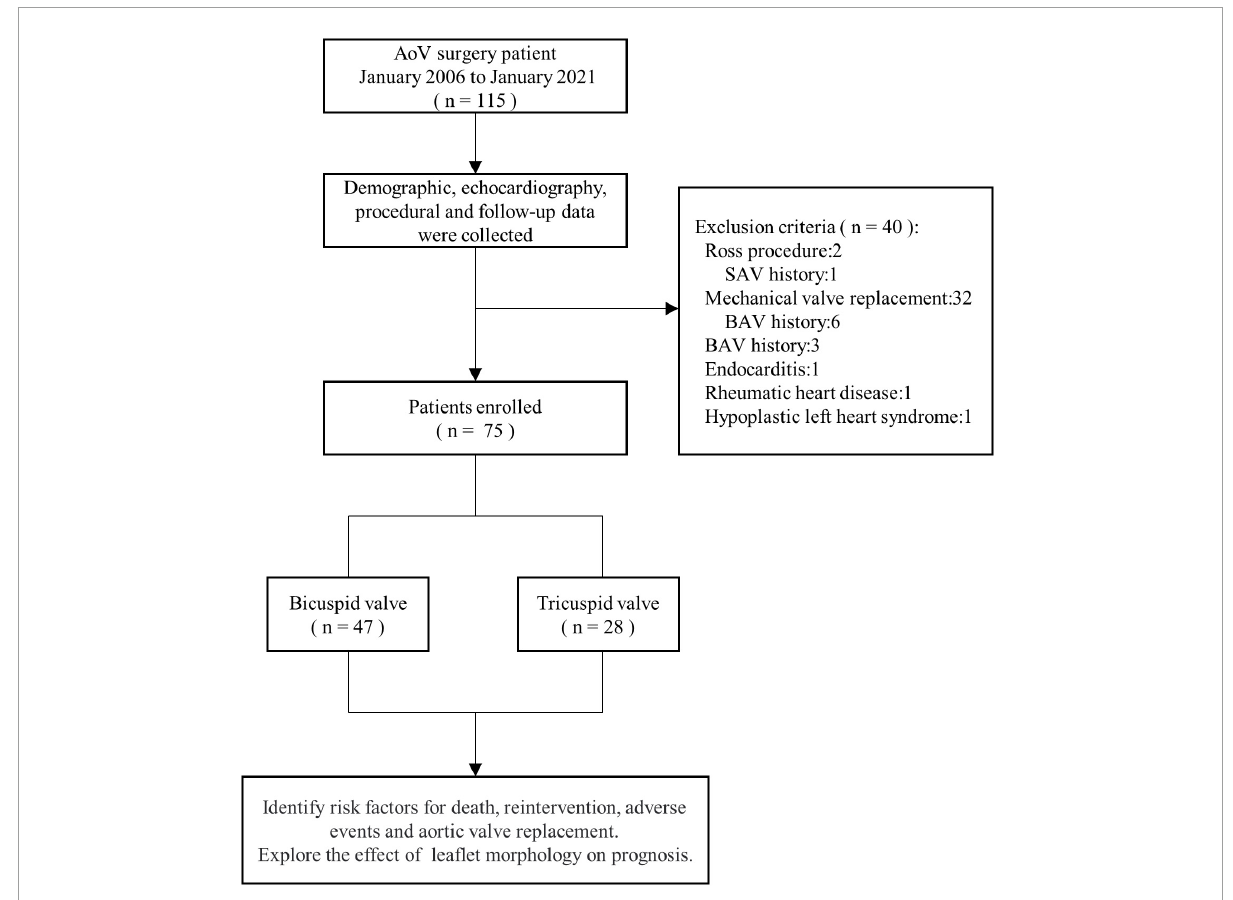
FIGURE1 Study flow chart. AoV, aortic valve; BaV, balloon aortic valvuloplasty; SAV, surgical aortic valvulotomy.